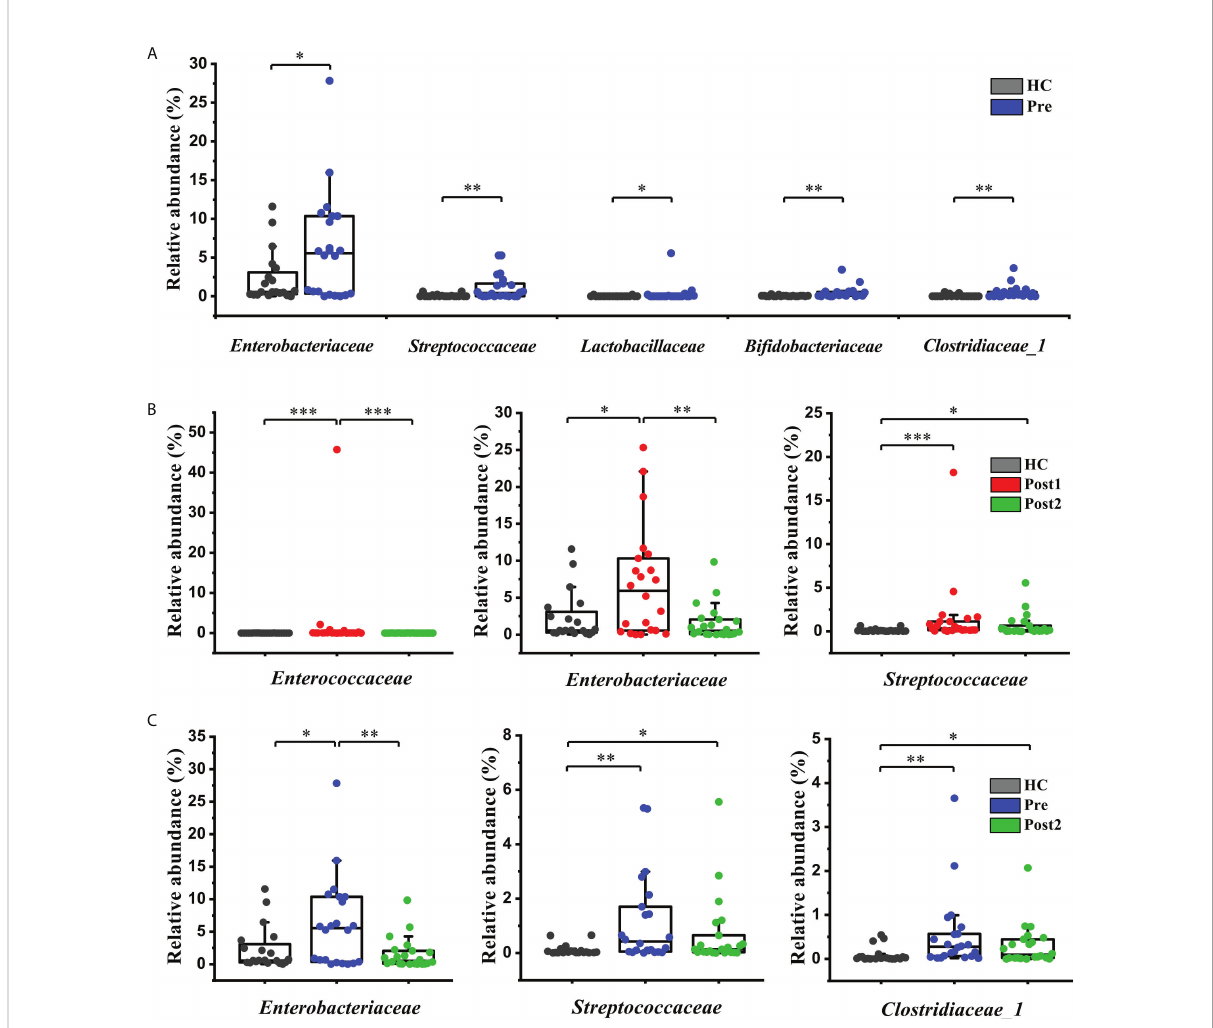
FIGURE 3 Microbiome phylotype alterations at the family level. (A) The relative abundances of fi ve families were signi fi cantly different between the healthy control group ( n = 20) and at Pre ( n = 22). (B) Enterococcaceae , Enterobacteriaceae , and Streptococcaceae were signi fi cantly increased at Post1 ( n = 22) compared with the healthy control group ( n = 20) but showed a declining tendency at Post2 ( n = 22). (C) Enterobacteriaceae , Streptococcaceae , and Clostridiaceae_1 were reversed at Post2 ( n = 22) compared with Pre ( n = 22). The box plot illustration is provided in Figure 2 , * P < 0.05, ** P < 0.01, *** P <